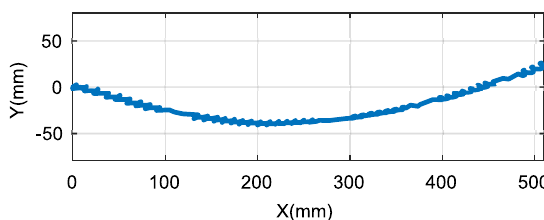
Fig. 17 Trajectory of M 22 (COG) of translational locomotion (wave parameters are A = 0.13 π , ω = π/ 20 , and β = 3 π/ 2